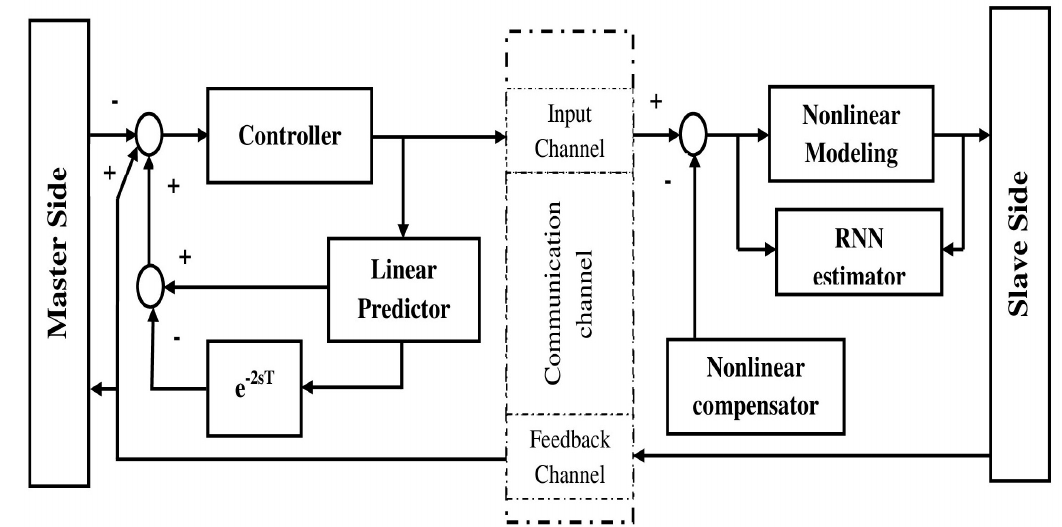
Figure 5. End-to-end system structure of the RNN-based model mediated bilateral teleoperated system developed in [68].